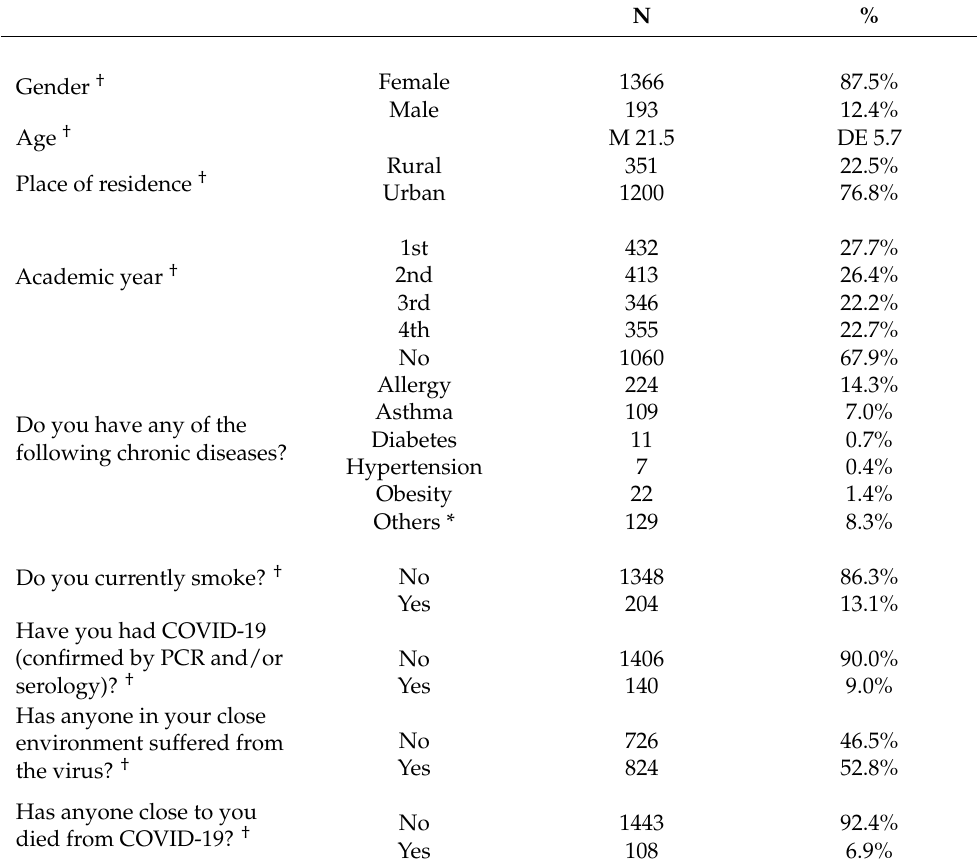
Table 1. Sociodemographic variables of the sample and questions related to